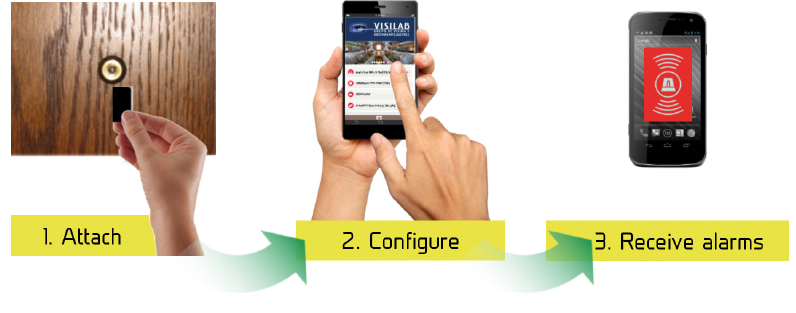
Figure 19. Peephole demonstrator.